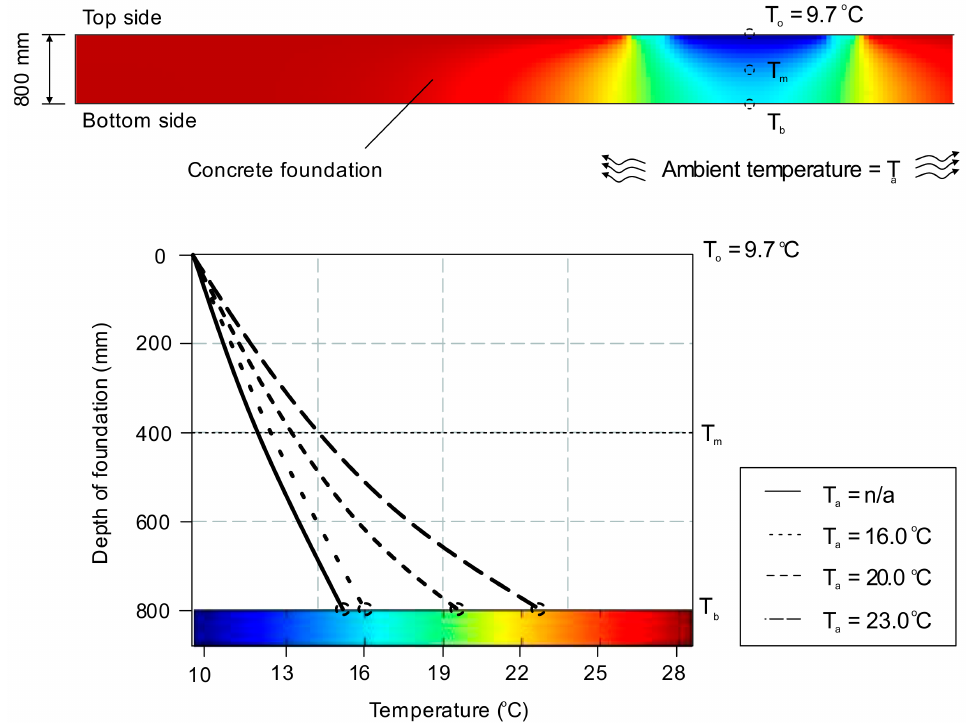
Figure 7. Temperature profile along the cross section of concrete foundation at 310 ◦ orientation with the effect of ambient